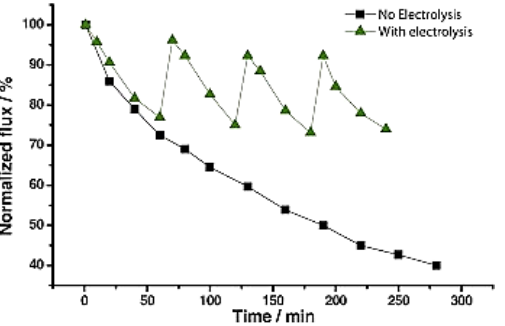
Figure 3. Time behaviour of normalized flux for CNS/PVDF membrane with and without electrolysis. Reprinted from [87], with permission from Elsevier.